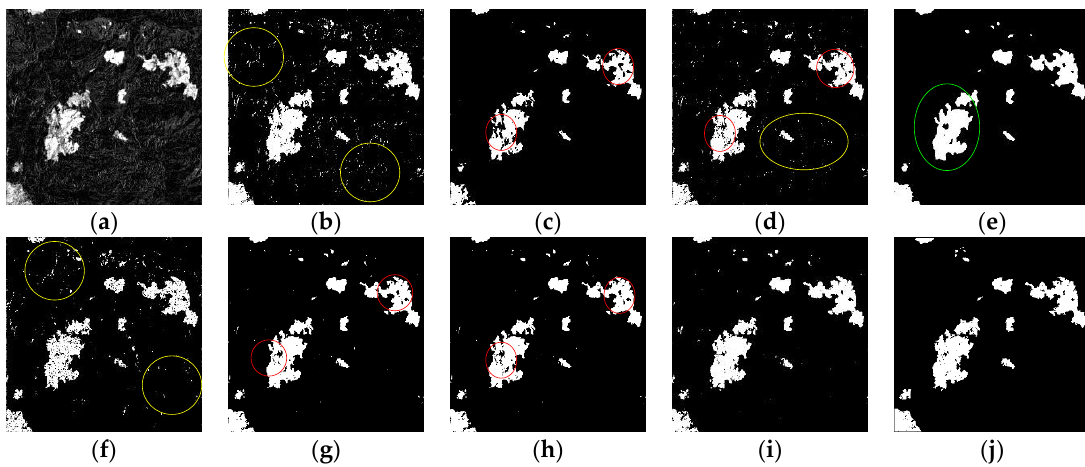
Figure 8. Results of the Mexico dataset. ( a ) difference image. ( b ) KI. ( c ) MRF+EM. ( d ) FCM. ( e ) FLICM. ( f ) GA-mask. ( g ) GA-FCM. ( h ) MOEA/D. ( i ) Proposed M-DECD. ( j ) Reference map. Yellow ovals refer to the false detection areas of the comparison algorithms compared with the M-DECD, and the red ovals refer to the miss-detection areas of the comparison algorithms. Green ovals refer to over-smoothing region.